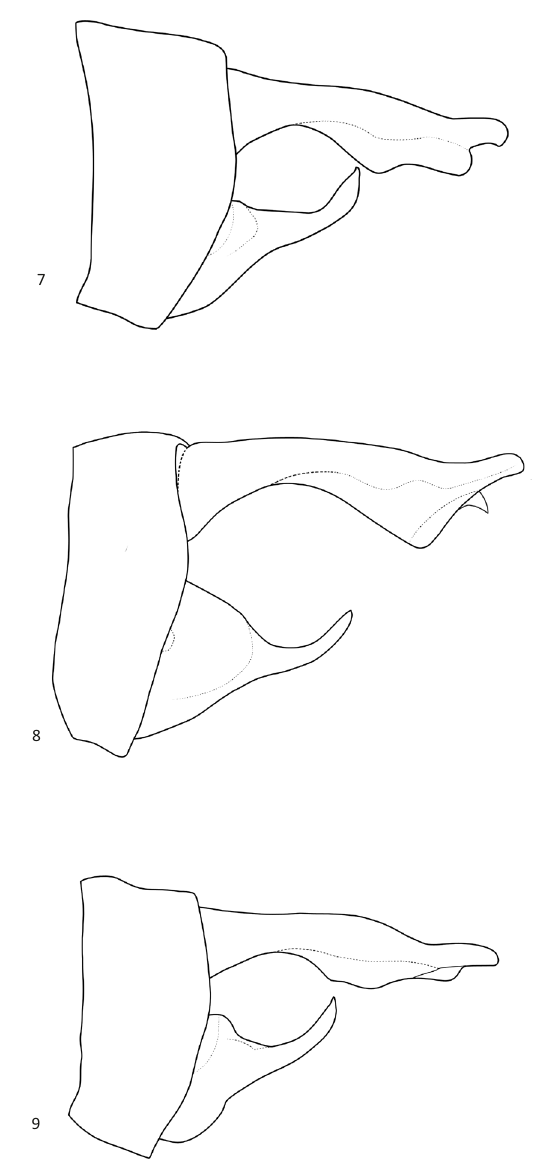
laterally and on anterior carina, middle and posterior lobes black. Lateral posterior part of the middle lobe produced outwards (Image 5) as a rounded projection bearing a few denticles, protruding well beyond the propleuron in dorsal view, above this projection a small depression and another larger depression placed more dorsally (Image 5). Propleuron black. Synthorax almost entirely black, except venter which is pale, and some brown patches near the antealar carina and the coxae. A distinct peak is present on the